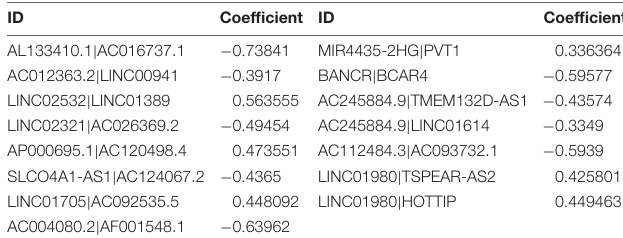
TABLE 1 | Prognostic IRlncRNAPs and their corresponding